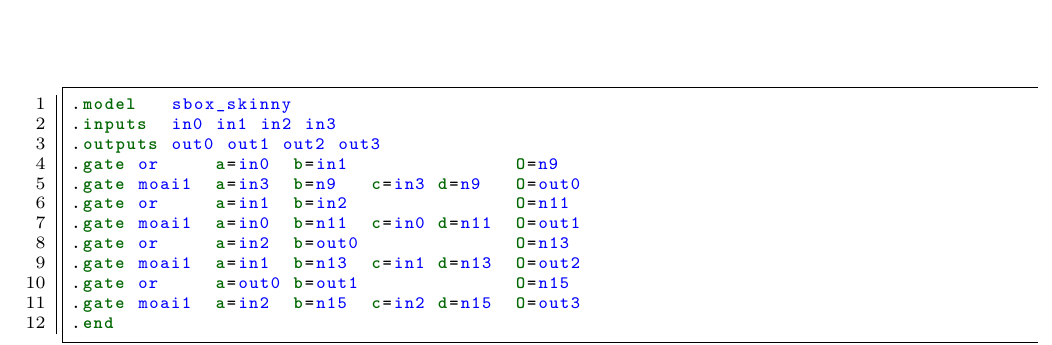
Figure 5: Area-optimized hardware implementation of SKINNY Sbox using 13.33 GE with the standard cell library of the UMC 180nm logic process.